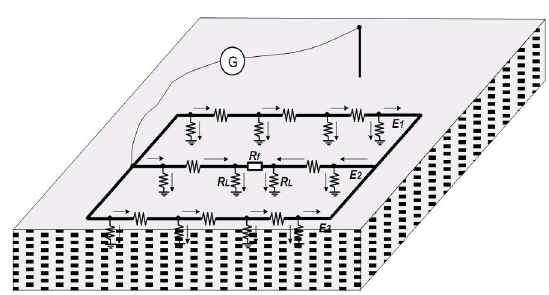
Figure 4. (a) Grounding Device under Test, (b) Current Distribution with Damaged Horizontal Element, (c) Equivalent Circuit of